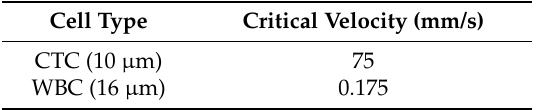
Table 3. Critical flow rates of the microfilter with the optimal thickness and